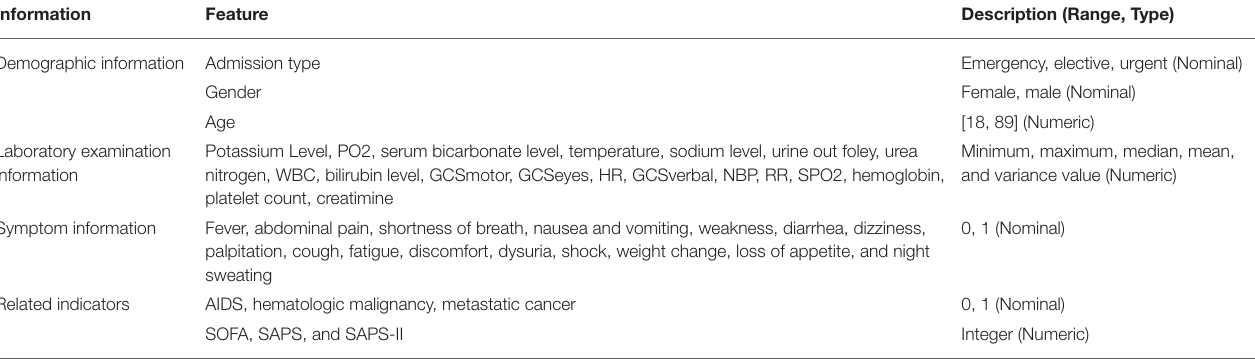
TABLE 1 | Feature information of the health condition of sepsis